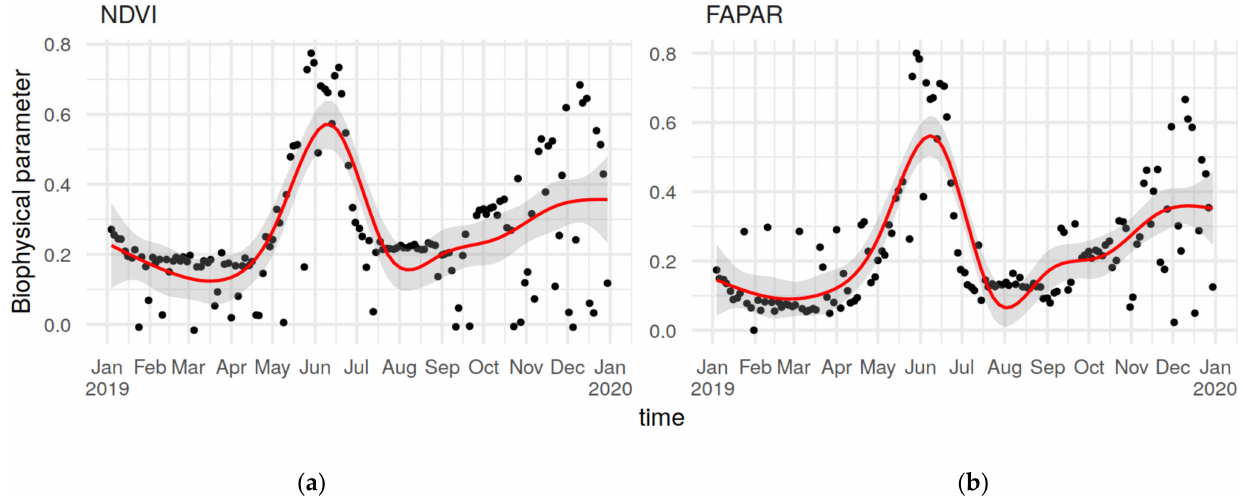
Figure 2. Time-series plots of averages from EO biophysical parameters NDVI ( a ) and fAPAR ( b ) over study area during 2019. Red lines represent smoothened curves fitted in time-series with local